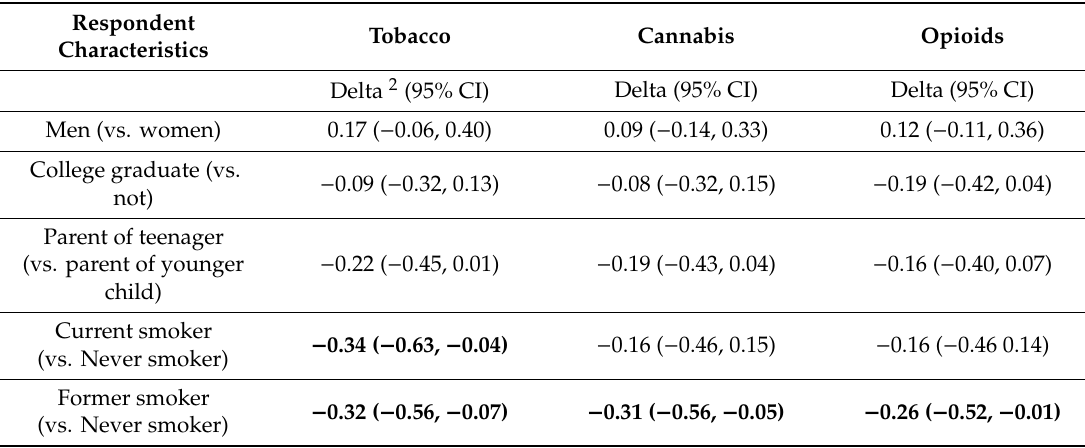
Table 3. Di ff erence in perceived parental control over their child’s initiation of tobacco, cannabis, and opioid use ( n = 400) 1